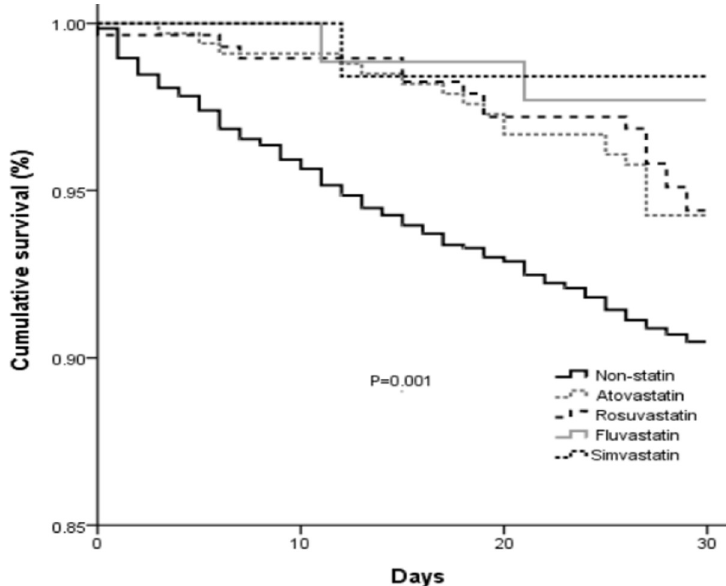
Fig 1. Kaplan–Meier survival analysis of 30-day mortally of cirrhotic patients with bacterial infections using different kinds of statins, compared to non-statin users.